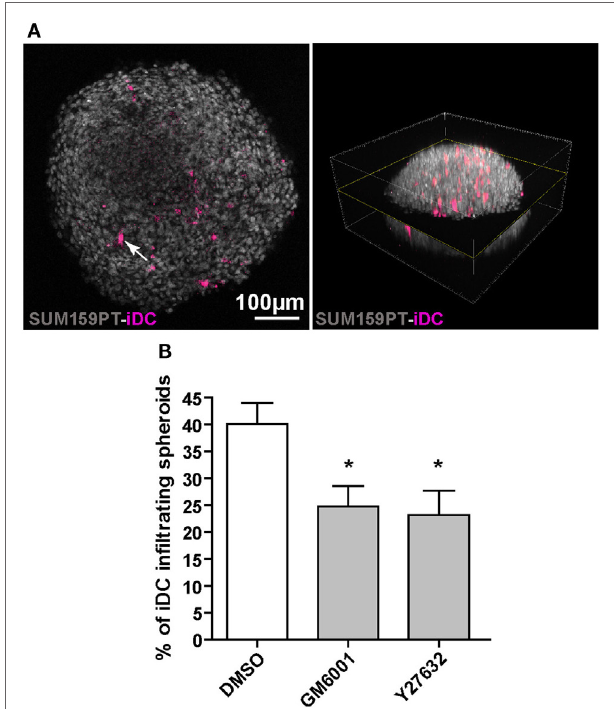
FigUre 4 | Immature dendritic cells (iDC) adopt both amoeboid and mesenchymal three-dimensional (3D) migration in tumor spheroids. SUM159PT cell spheroids were coincubated for 3 days with CellTracker- stained DC, with or without drugs. (a) Multiphoton acquisition of DAPI stained spheroids (gray) infiltrated by CellTracker-stained iDC (purple). A spheroid cross-section (left) set in the 3D spheroid reconstitution is shown (right). The arrow indicates a CellTracker-stained iDC located inside the spheroid. (B) Quantification of iDC infiltration into spheroids, with or without inhibitors. Results are expressed as the percentage of iDC inside spheroids (100% corresponds to iDC inside plus iDC at the periphery). Results are expressed as mean ± SEM of five independent experiments. * P < 0.05.